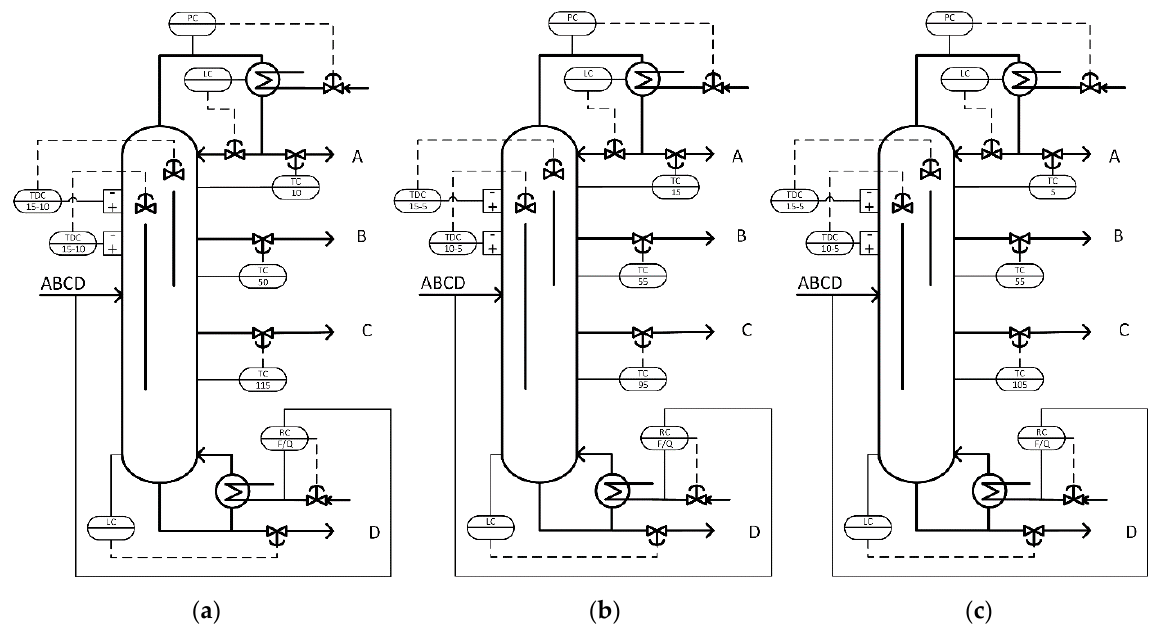
Figure 7. Resulting control structures for ( a ) Mixture 1, ( b ) Mixture 2, and ( c ) Mixture 3. The numbers under the TCs and TDCs indicate the theoretical stages to be controlled.